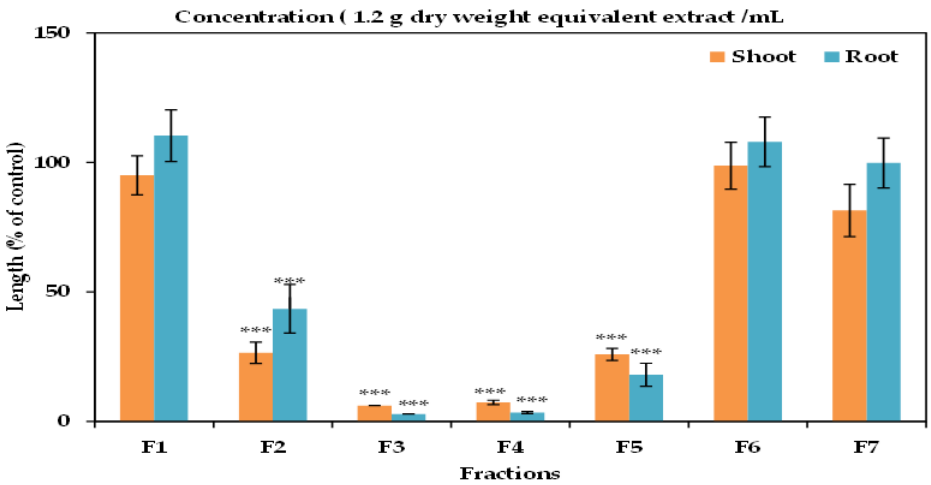
Figure 1. E ff ect on the seedling growth of cress of all fractions of the extracts of Wedelia chinensis that has been obtained from the column of Sephadex LH-20: cress seeds were exposed to the concentration equivalent of the extracts gained from 1.2 g DW (dry weight) of Wedelia chinensis / mL for F1 (20% aqueous methanol), F2 (30% aqueous methanol), F3 (40% aqueous methanol), F4 (50% aqueous methanol), F5 (60% aqueous methanol), F6 (80% aqueous methanol), and F7 (methanol). The values are mean ± SE for each treatment from the two independent experiments with 10 seedlings. Asterisks show major variations between treatments and control: *** p < 0.001 (ANOVA one way and least significant di ff erence (LSD) test post hoc).